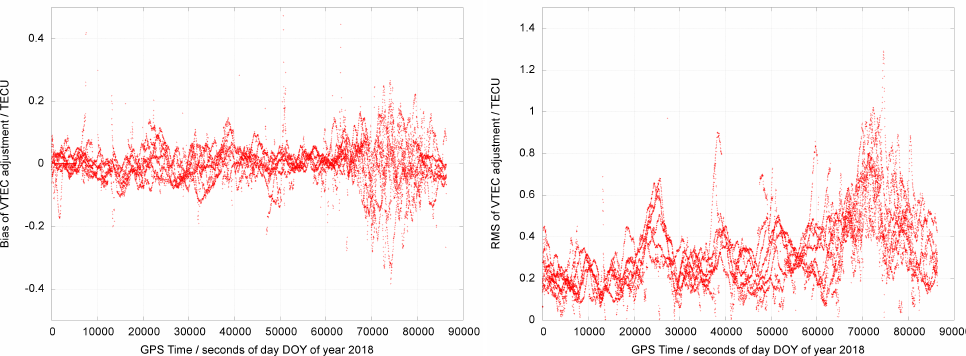
Figure 4. The bias ( left ) and RMS ( right ) of the residuals of the VTEC fitting per satellite (vertical axis in TECU) vs. time (horizontal axis in seconds of the day) is represented during the day 12 June 2018.